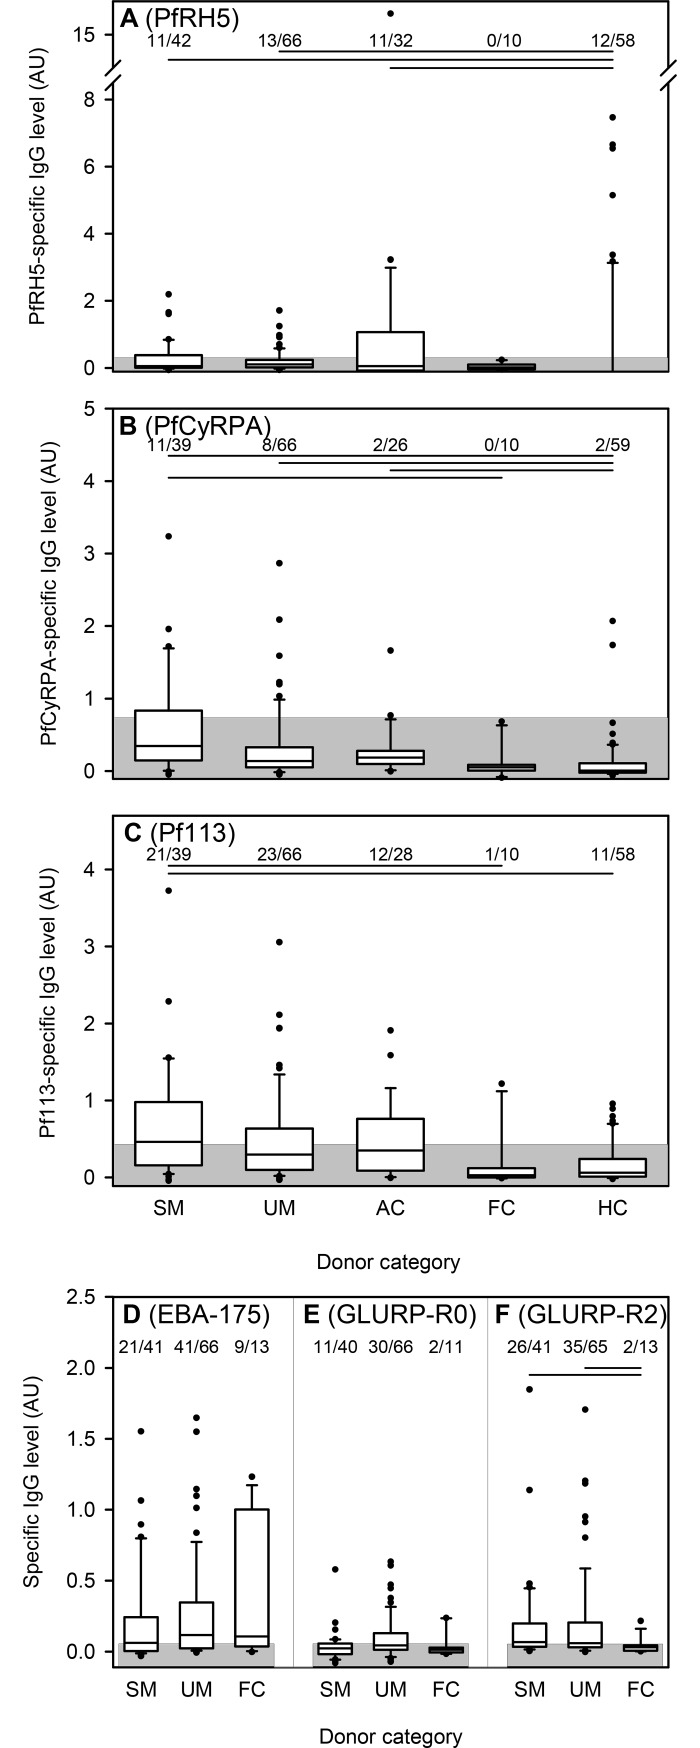
Merozoite-specific IgG according to clinical category.Levels (AU) of IgG specific for PfRH5 (A), CyRPA (B), Pf113 (C), EBA175 (D), GLURP-R0 (E) and GLURP-R2 (F) in plasma of individual children according to clinical category: SM (severe P. falciparum malaria), UM (uncomplicated P. falciparum malaria), FC (non-parasitemic febrile controls), AC (asymptomatic controls), HC (non-parasitemic healthy controls). Please refer to Materials and Methods for category definitions. The number of individuals with IgG above cut-off and the total number of individuals in each clinical category are given along the top of each panel. Horizontal lines along the top of the panels indicate statistically significant (P<0.05) differences between groups. Data presentation otherwise as in Fig 1B. The presented data is from one experiment.